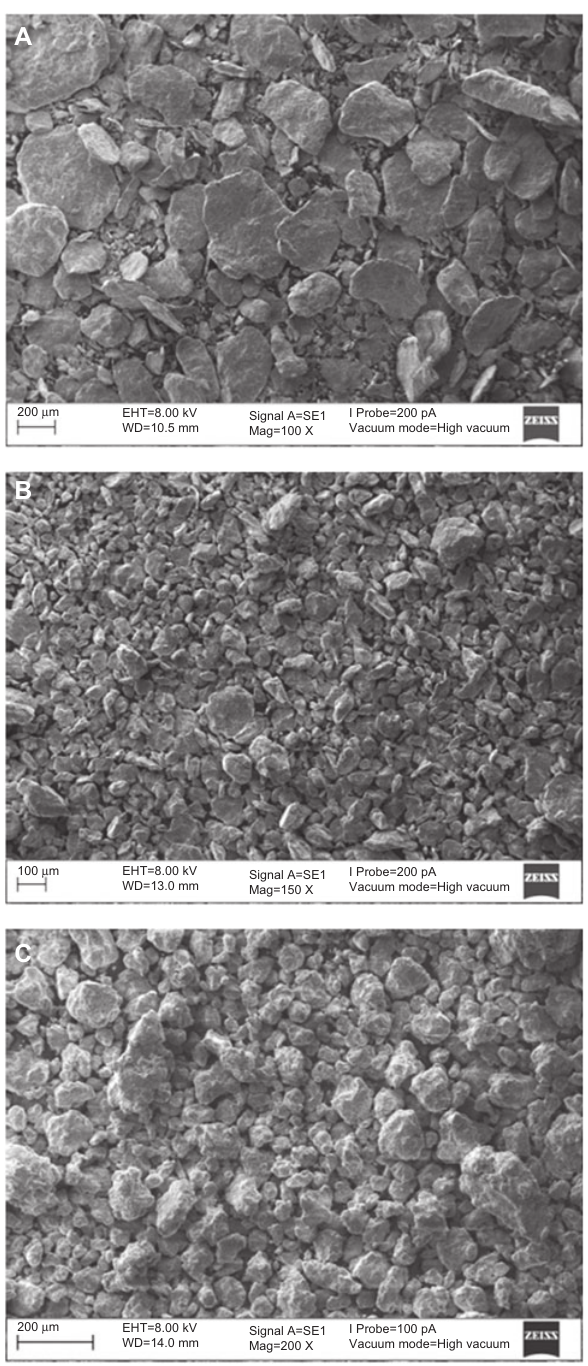
Figure 3 Morphology of the milled Al powders for: (A) 0.5 h, (B) 2 h, (C) 7